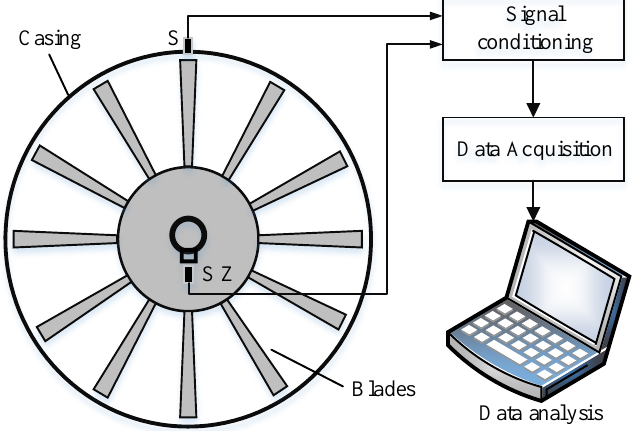
Figure 1. The schematic of the blade tip timing (BTT) system.